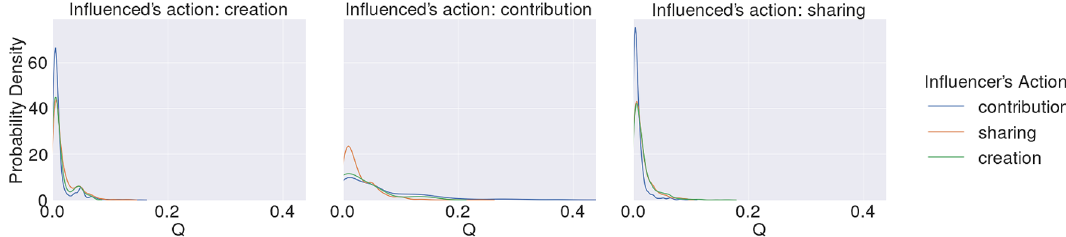
Figure 1. Probability density functions of conditional probabilities P ( U y | V x )) . Probability densities of influenced individual U performing action y given influencer V performs action x over users in the calibration data. The long-tailed distributions illustrate the heterogeneity of P ( U y | V x )) among all existing relationships, with a few relationships having high conditional probabilities of action and many having relatively lower probabilities of action. This heterogeneity was highest for social influence on the influenced individual’s contribution actions, i.e. the probability density functions for P ( U y | V x )) , where y = contribution , had a much longer